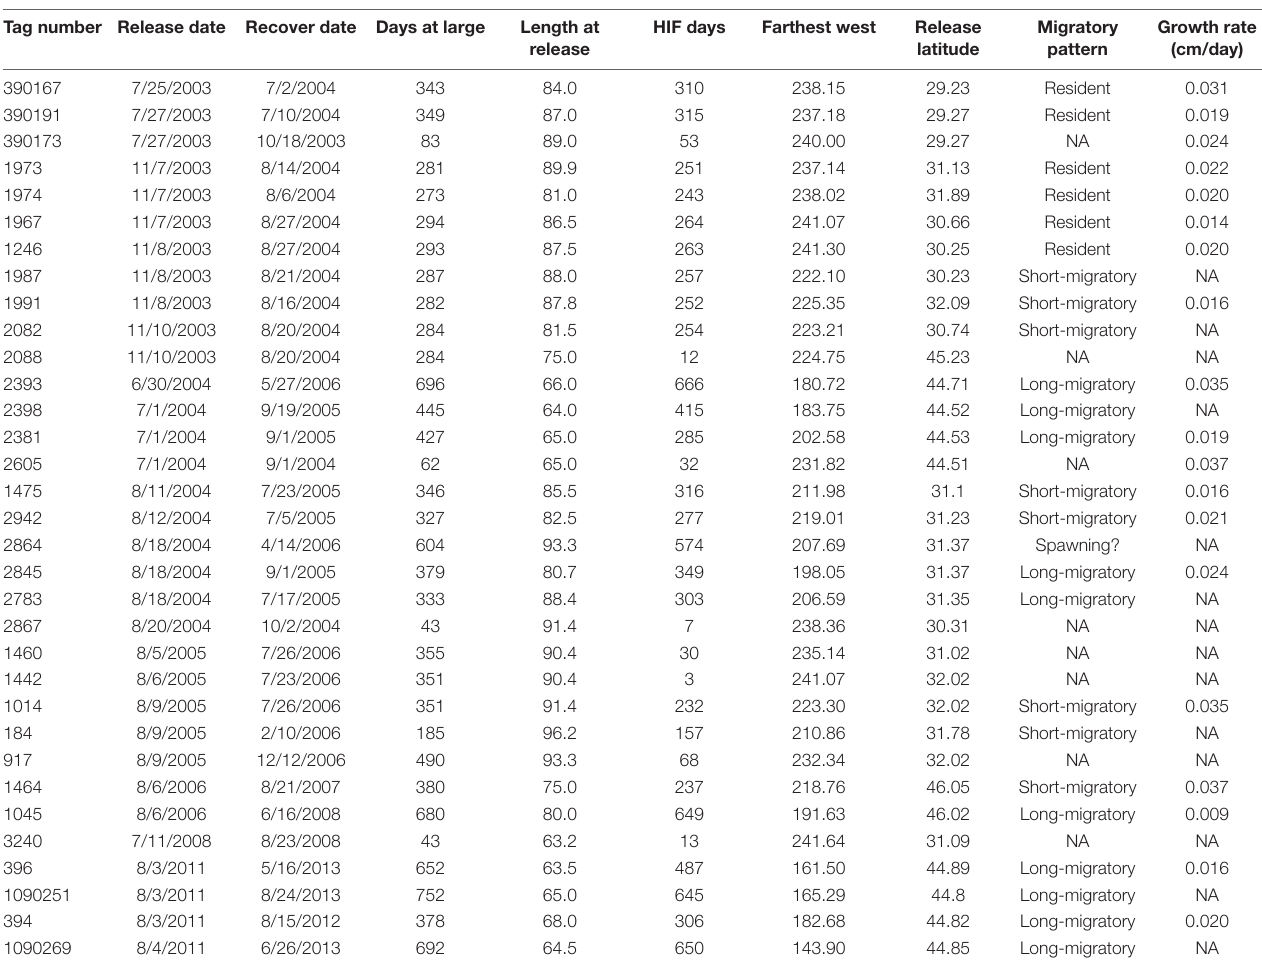
TABLE 1 | Summary of 33 tagged albacore included in this